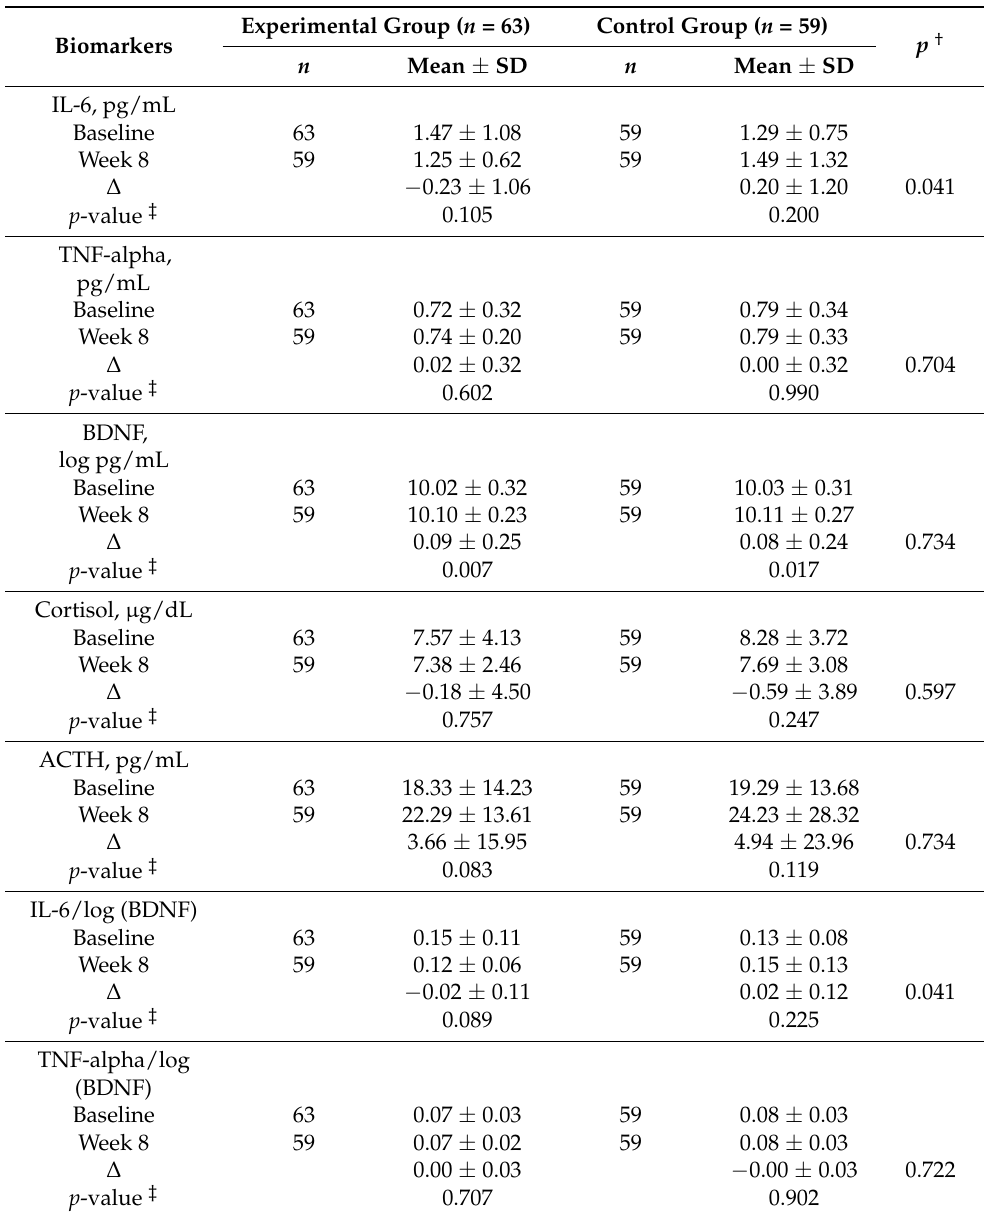
Table 5. Comparison of the changes in blood biomarkers from baseline to eight weeks of intervention between the two study